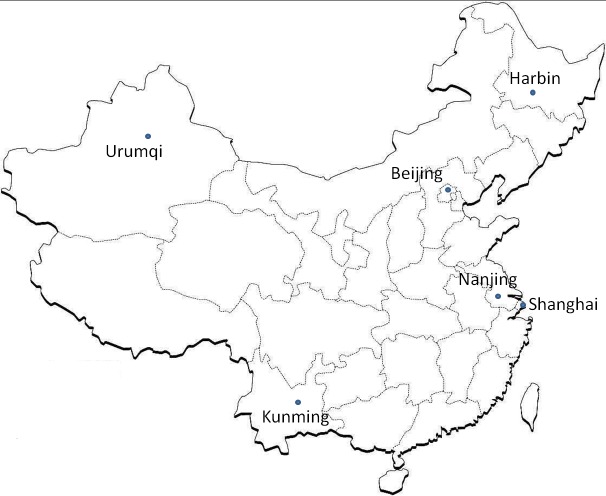
Locality map of different cities included in this study.A total of 835 samples from pediatric patients presenting with the symptoms of respiratory tract infection (RTI) belonging to five different geographical locations in China were collected from January to December 2016. Two-hundred-and-forty-three samples were from Beijing, which is located in mid-north China; 100, from Shanghai, located in the east; 275, from Kunming, Yunnan province, located in the south; 140, from Harbin, Heilongjiang province, located in the north; and 72, from Urumqi, Xinjiang province, located in the west. Ten M. pneumoniae-positive DNA samples isolated from 10 clinical specimens were collected from pediatric patients in Nanjing, which is close to Shanghai.